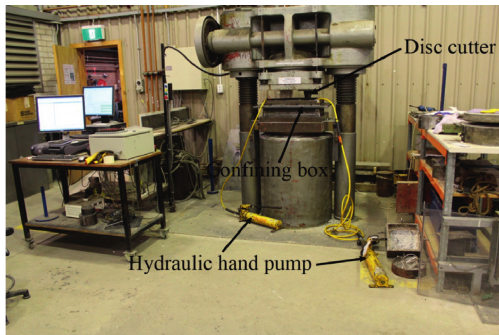
Figure 5: The indentation test platform.